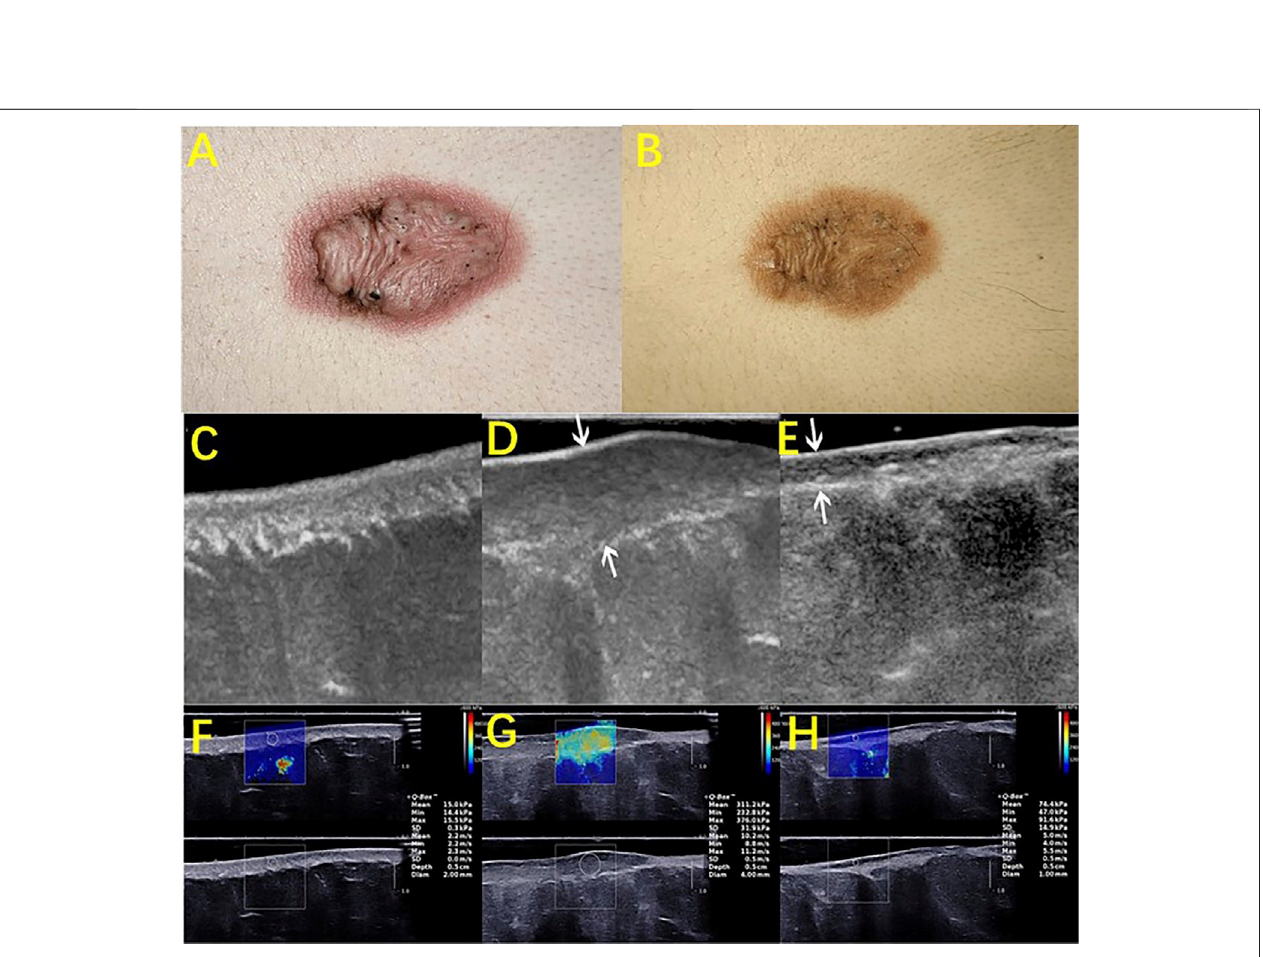
FIGURE 2 | HFUS assessing the therapeutic ef fi cacy of scars. A keloid before (A) and after (B) intralesional steroids injection. B-mode ultrasound images (longitudinal) of normal skin (C) , pretreated keloids (D) , and post treated keloids after an intralesional steroid injection (E) . (F) , (G) , and (H) are the corresponding elastographyimagesof (C) , (D) ,and (E) ,respectively.Images (A) to (H) werecapturedfromthesamepatient.Arrowsinimages (D) and (E) showedanobviousreduction in the scarthickness after treatment. The depth× width ofthe images (C – E) were1.5 ×2.25, 1.6 ×2.4, and 1.5× 2.25 (cm), respectively. Asshown inthe images, the quantitative elasticity values, including Young ’ s modulus and shear wave velocity, decreased after treatment.